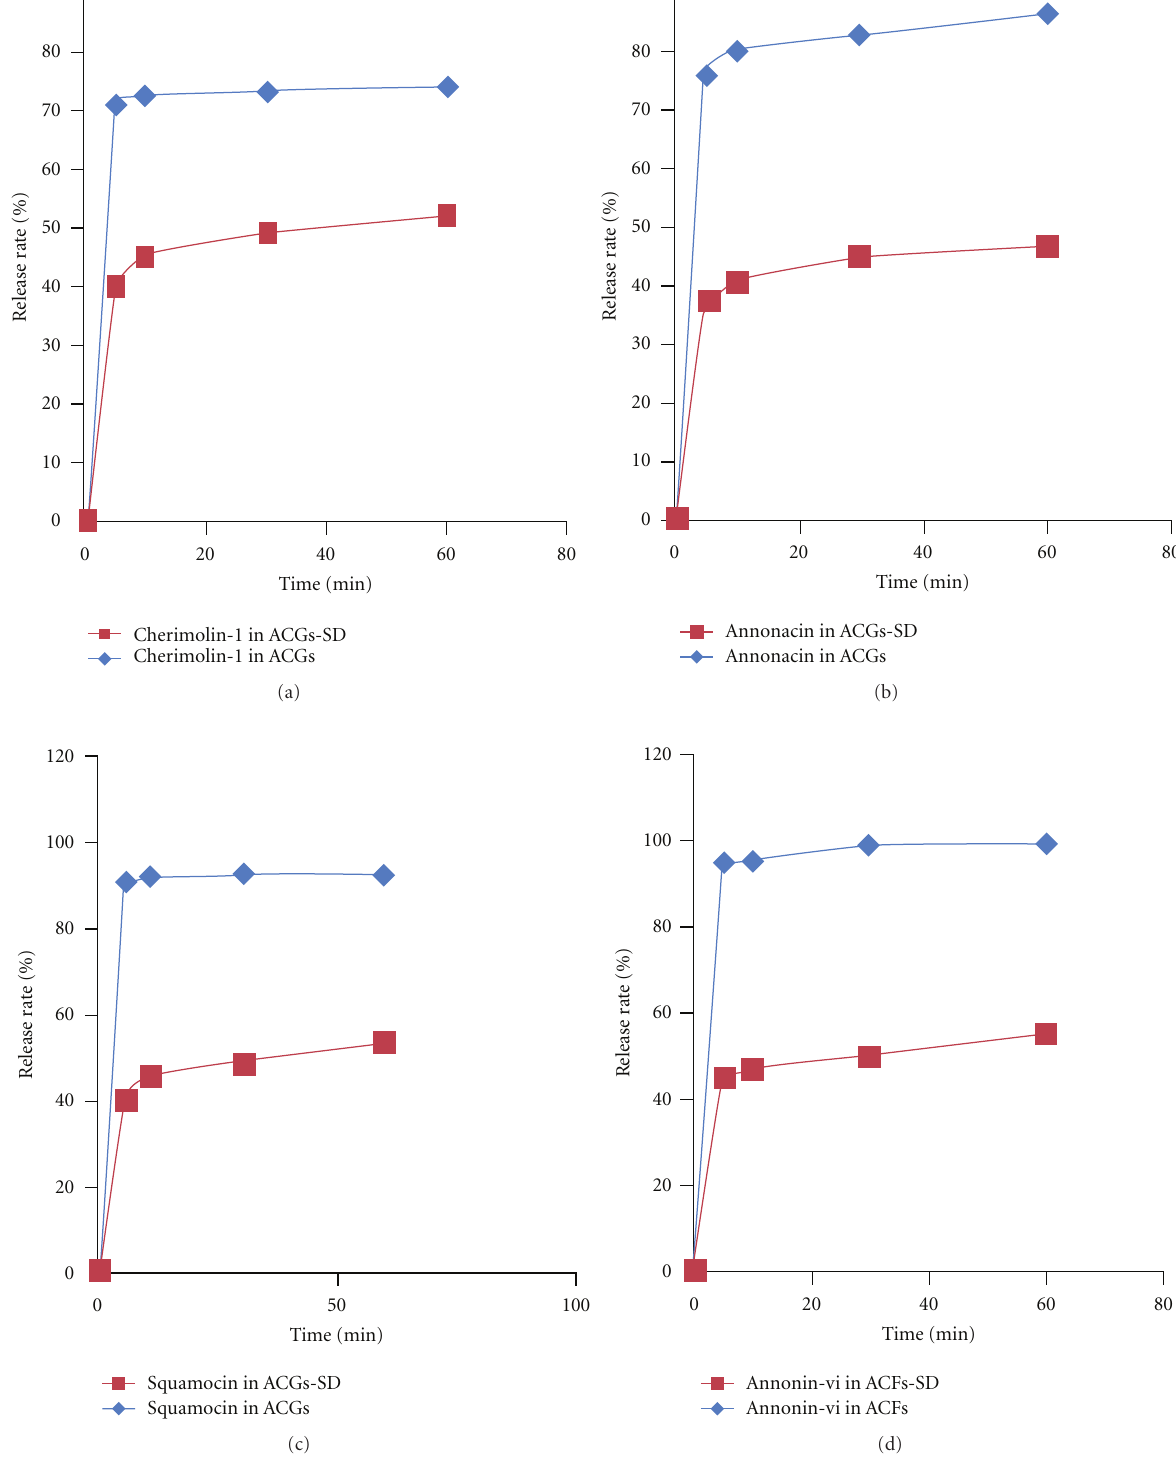
Figure 3: Dissolution profiles of ACGs and ACGs-SD in PBS (pH 6.8) at 37 ◦